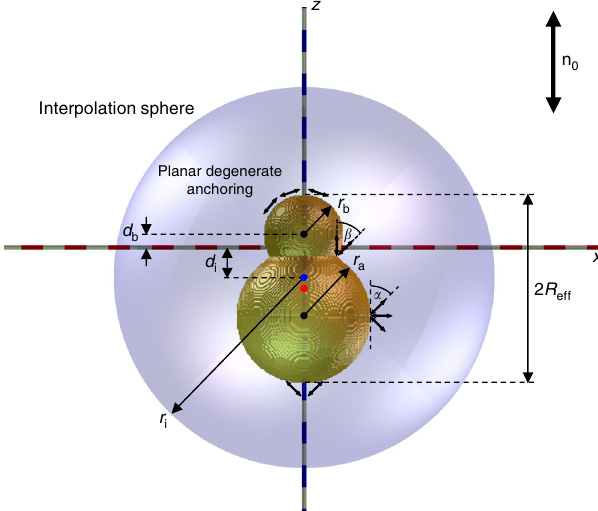
Fig. 2 Model of a colloidal particle consisting of two interpenetrated spheres used in calculations. The lower sphere has a constant radius r a and is positioned at a distance − r a from the coordinate origin (note axes x and z are indicated by dashed red and blue lines, respectively). The upper sphere ’ s radius r b and distance d b of the upper sphere center from the origin are particle geometrical parameters varied in the process of analysis. The anchoring on the upper sphere is planar degenerate, while that on the lower sphere is conic degenerate with a tilt angle α . At the neck, where two spheres with distinct anchoring meet, the angle between two anchoring directions is represented with angle β . Blue sphere indicates the interpolation sphere of radius r i and blue dot depicts its center displaced by d i from the origin, both r i and d i are varied in the analysis to determine the center and magnitude of the elastic multipoles. Red dot represents geometrical center of the composite colloidal particle whereas half of the composite particle length along z -axis represents the effective particle radius R